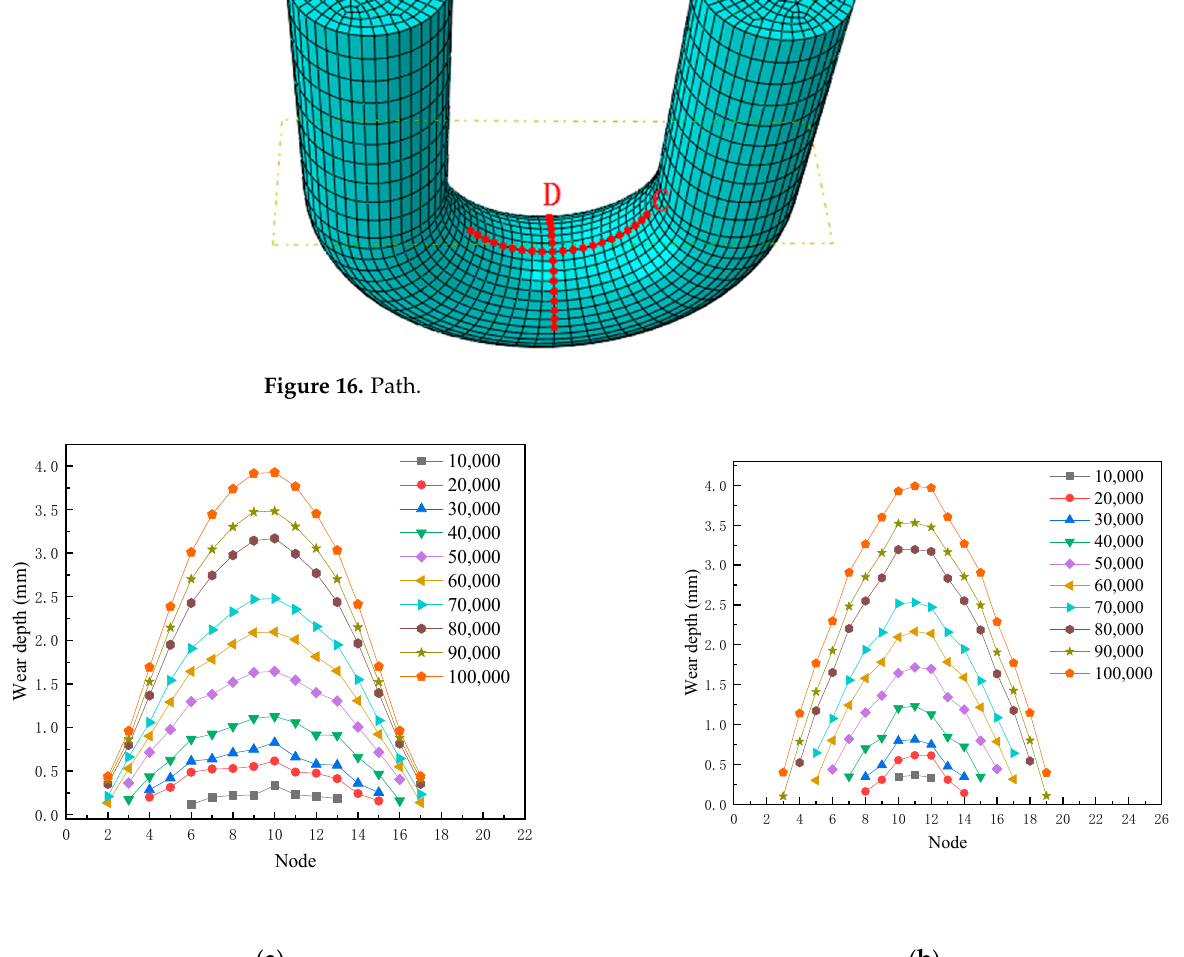
Figure 17. Variation of node wear depth for different paths, ( a ) C path; ( b ) D path.